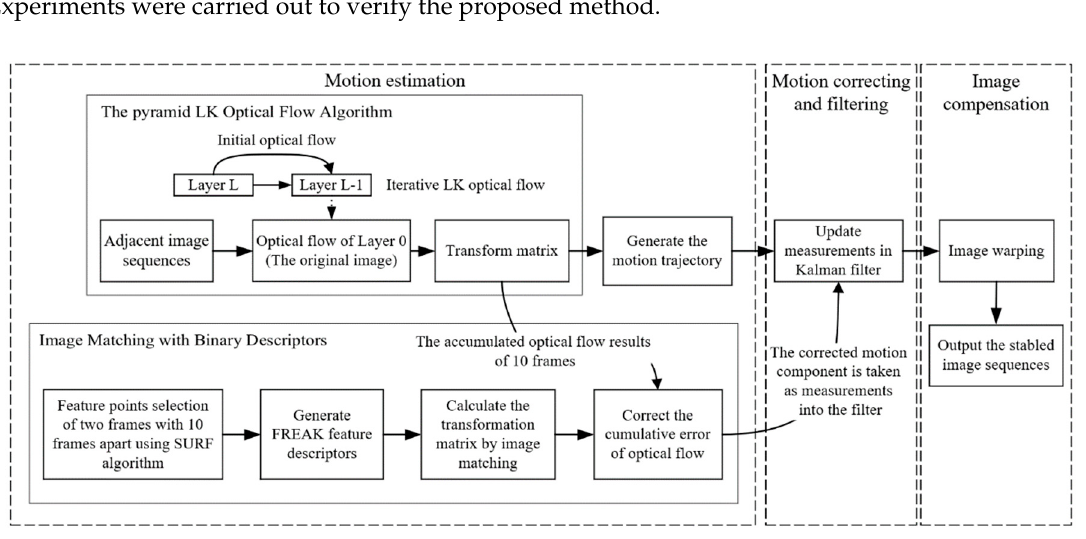
Figure 7. Block diagram of the specific framework of proposed algorithm.